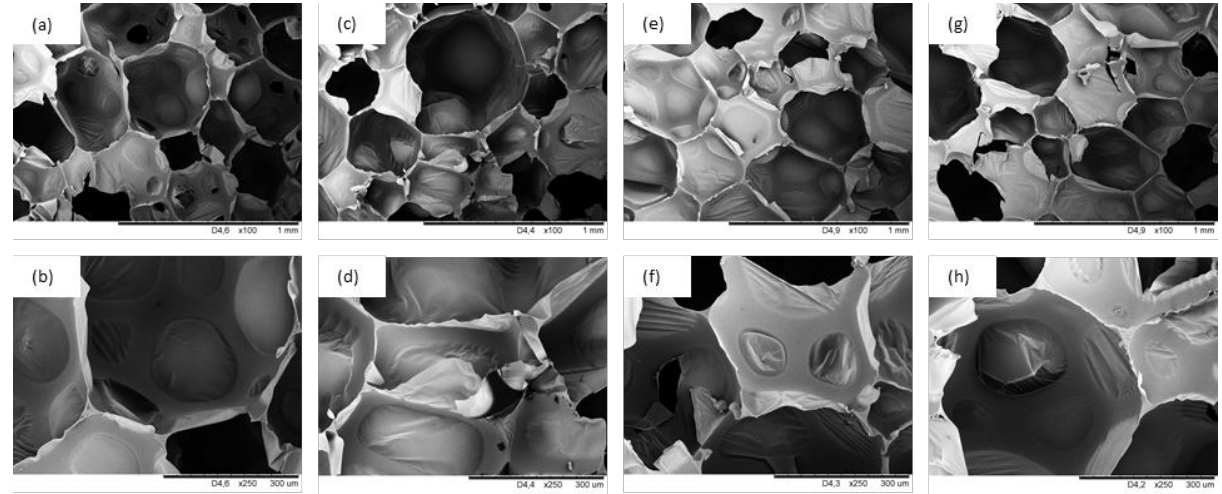
Figure 5. Cellular morphology of ( a , b ) PUR_REF, ( c , d ) PUR_L, ( e , f ) PUR_L_K, ( g , h ) PUR_L_HA. As presented in Figure 6, on the addition of lavender fillers, the value of apparent density increases from 36.8 kg m −3 (for PUR_REF) to 37.4, 38.9, and 38.6 kg m −3 , for PUR_L, PUR_L_K, and PUR_L_HA, respectively. This may be explained by the fact, that the incorporation of lavender fillers, which are characterized by greater density than the PUR matrix. On the other hand, as shown in Table 2, the incorporation of lavender fillers increased the viscosity of PUR systems, limiting the expansion of the PUR systems and resulting in the formation of smaller cells. Therefore, the density of PUR composites is enhanced.